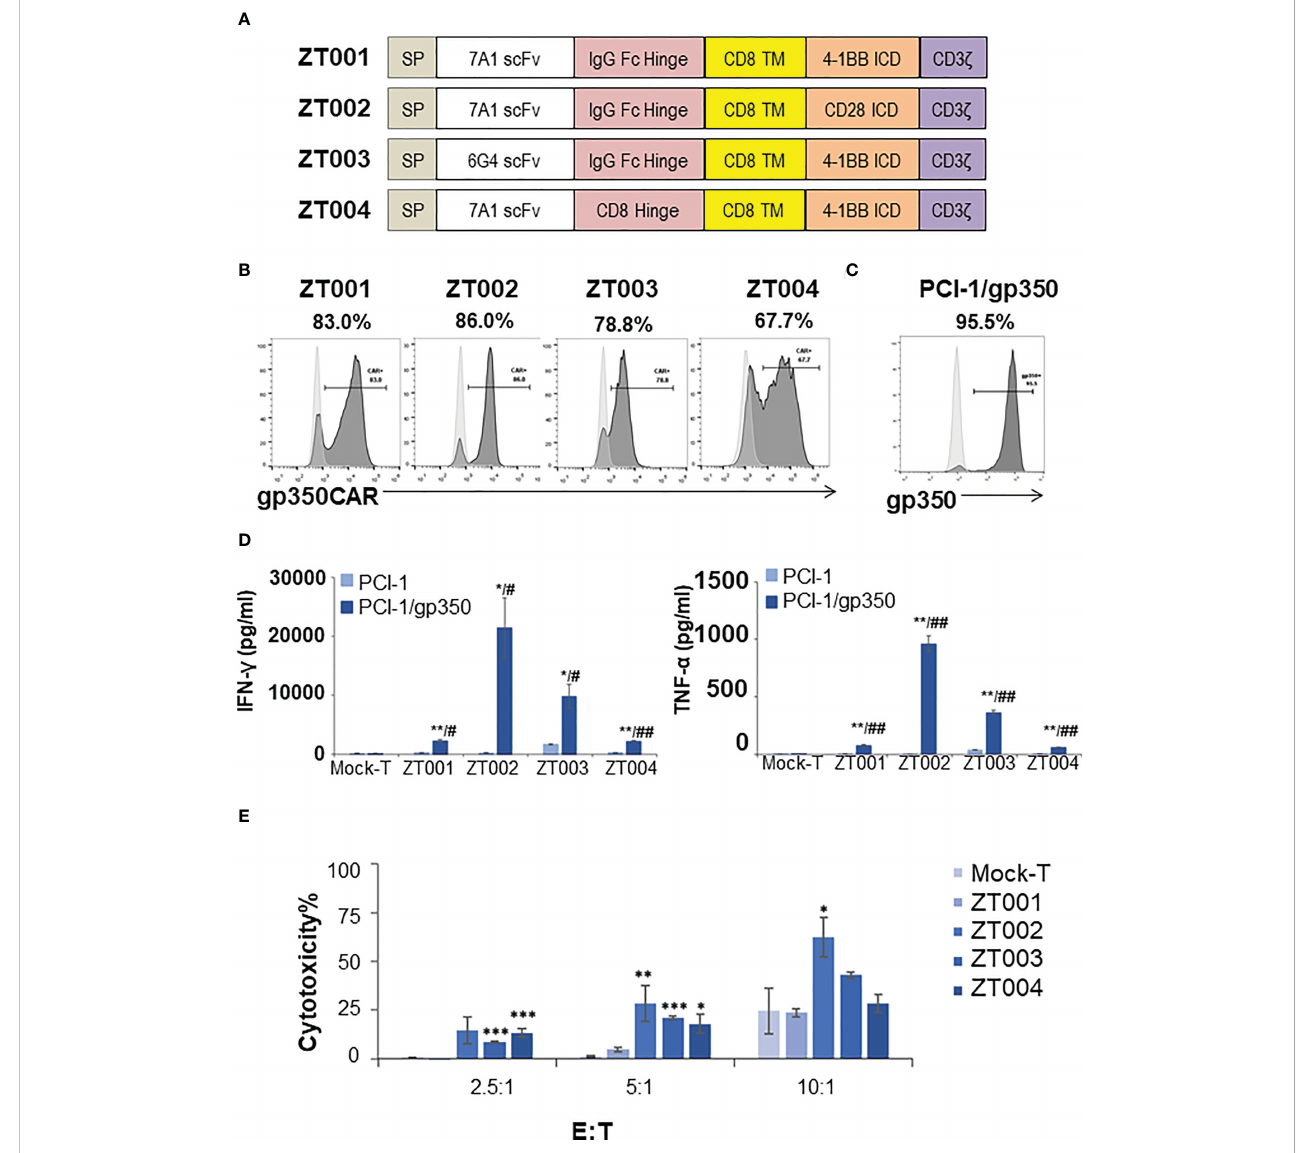
FIGURE 1 Testing of different lentiviral vectors incorporating different gp350CAR designs and selection of the best construct. (A) Schematic diagrams of LV constructs expressing gp350CAR. SP, signal peptide; scFv, single chain variable fragment (7A1 or 6G4); Hinge (IgG Fc or CD8); TM, transmembrane domain (all CD8); ICD, intracellular domain (CD28.CD3 z or 4-1BB.CD3 z ). (B) Flow cytometry analyses showing surface expression of the CAR on T cells transduced with four lentiviral constructs (ZT001, ZT002, ZT003 or ZT004). Transduced T cells (dark grey) are compared with mock-T cells (light grey). Percentages of gp350CAR-expressing cells are shown; representative example from triplicate transduction experiments performed with T cells derived from one donor. (C) Flow cytometry analyses of PCI-1 cells transduced to express gp350 (dark grey) compared with un-transduced cells (light grey). (D) IFN- g and TNF- a release. Mock-T and gp350 CAR-T cells were co-cultured with PCI-1 or PCI-1/gp350 cells for 16 hours at an E:T of 5:1 and the levels of IFN- g and TNF- a released in the medium were measured by ELISA. Data are presented as means from triplicates ± SD. Welch t-test and p-values after correction for multiple comparisons, CAR-T versus Mock-T cells, *P ≤ 0.05, **P ≤ 0.01, ***P ≤ 0.001. PCI-1/gp350 versus PCI-1, # P ≤ 0.05, ## P ≤ 0.01. (E) In vitro cytotoxicity comparison of four anti-gp350 CAR. Lactose dehydrogenase (LDH)-based cytotoxicity assay (16 hours culturing) was used to assess the cytotoxicity of four anti-gp350 CAR-T cells against gp350-positive human oropharyngeal cancer cell lines PCI-1 (PCI-1/gp350). Non-transduced T (Mock-T) cells were included as a control. These results are presented as means from triplicates ± s.d. Welch t-test and p-values after correction for multiple comparisons, compared to Mock-T, *, P < 0.05; **, P<0.01; ***, P <